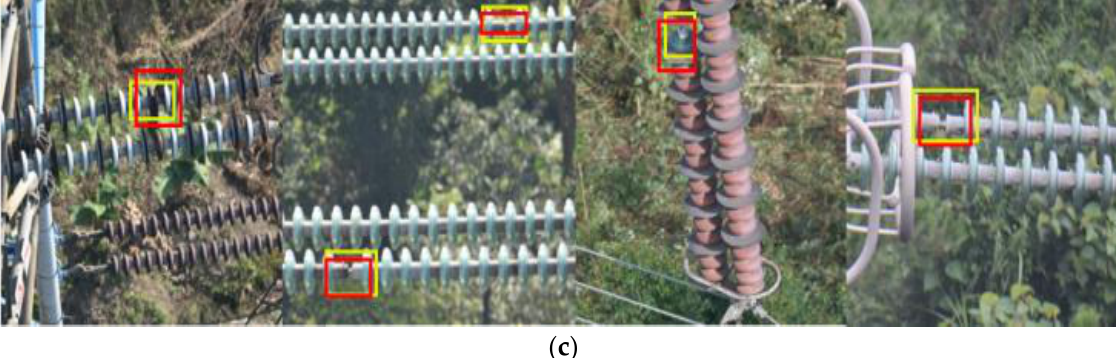
Figure 21. Ablation study results when using different techniques. ( a ) FPN+RA. ( b ) FPN+RA+CR. ( c ) FPN+RA+CR+ME. (FPN: Feature Pyramid Network. RA: RoI Align. CR: Cascade R-CNN. ME: Mask Extraction).